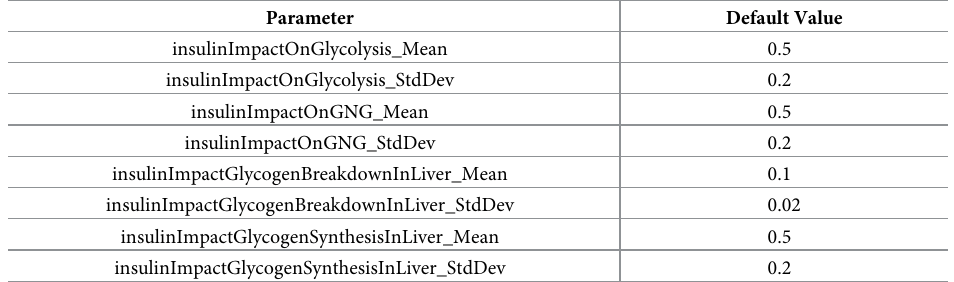
Table 2. Configurable parameters (and their default values) for the mean and standard deviation of normal distri- butions to determine the impact of insulinLevel on various metabolic